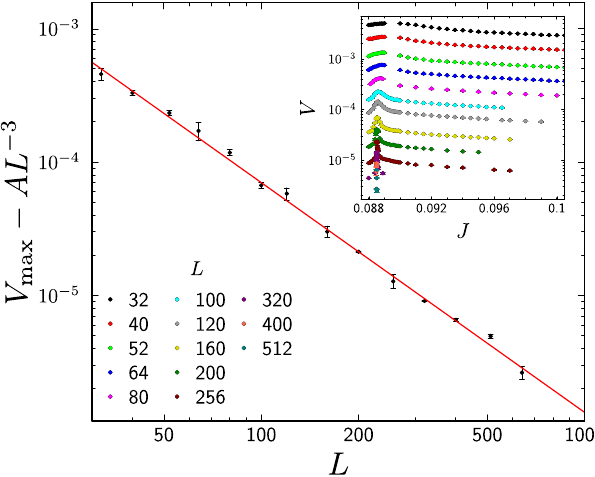
FIG. 16. V is shown as a function of system size on a double max logarithmic scale with the background contribution subtracted. Inset: Raw data for V plotted as a function of J on a semilog- arithmic scale for several values of L